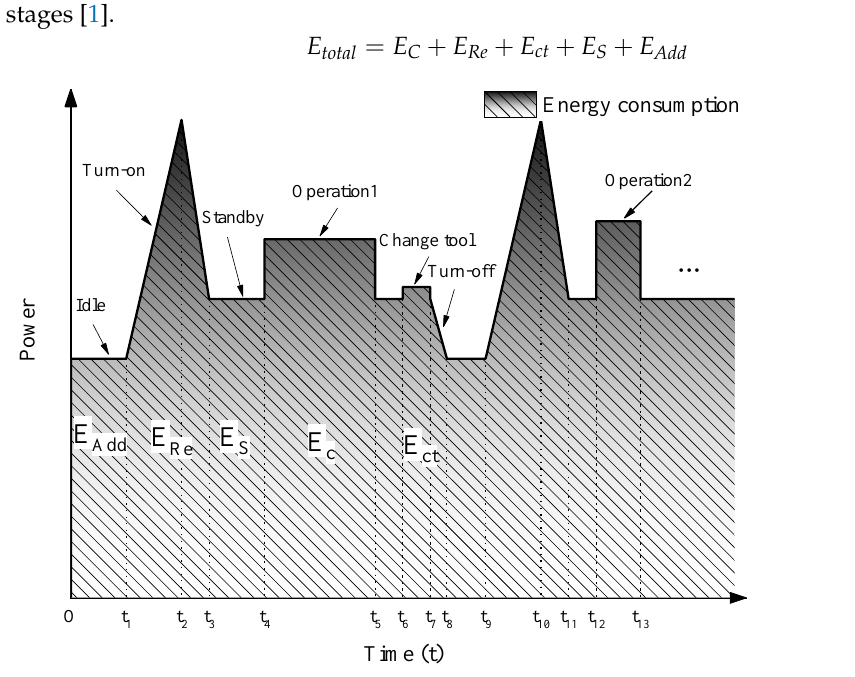
Figure 3. Schematic diagram of energy consumption distributions for different running states.